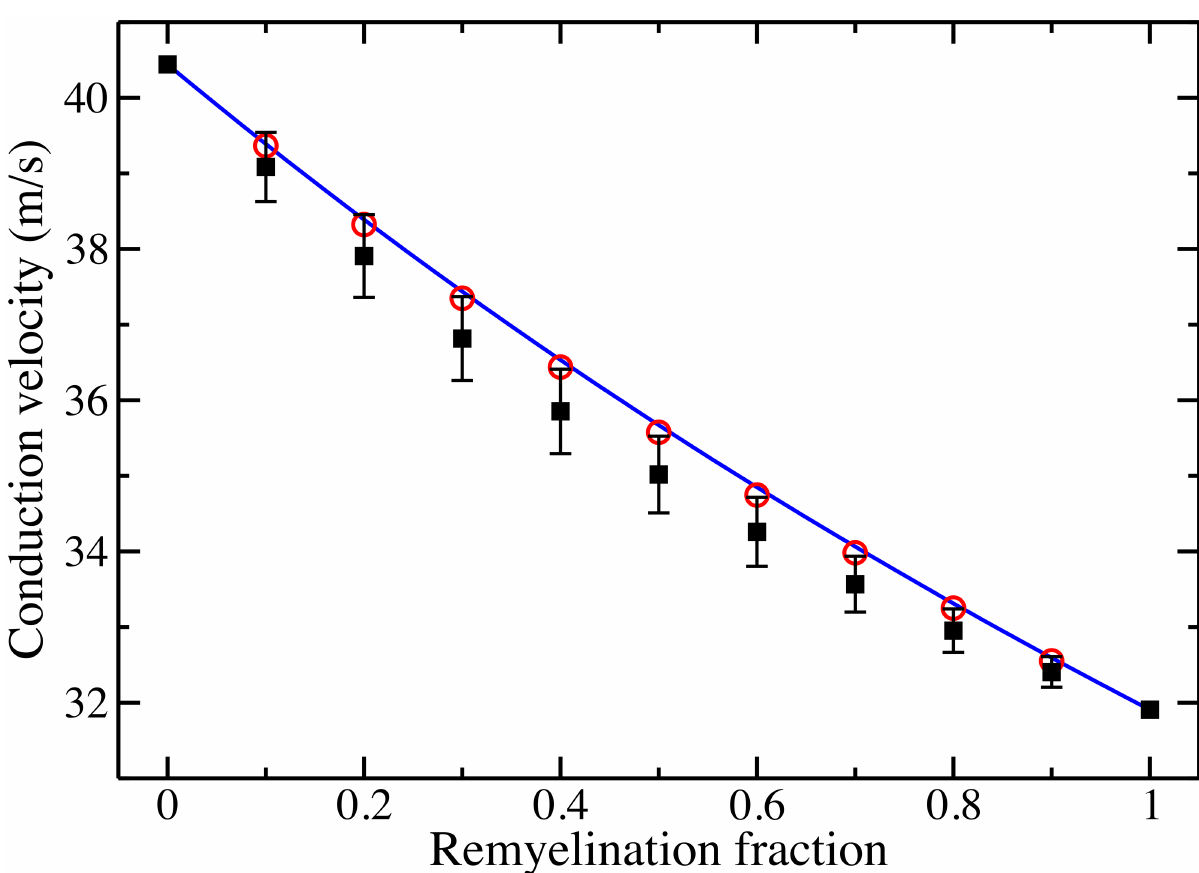
Fig 1. Conduction velocity along progressively remyelinated axons. The black squares represent the average CV (and standard deviation) for 500 model neurons with a given fraction of remyelinated segments. The blue solid curve is the benchmark velocity (cid:22) v ð p Þ . The red circles represent the CV for an axon with uniform internode length given by the average internode length of the remyelinated model neurons.